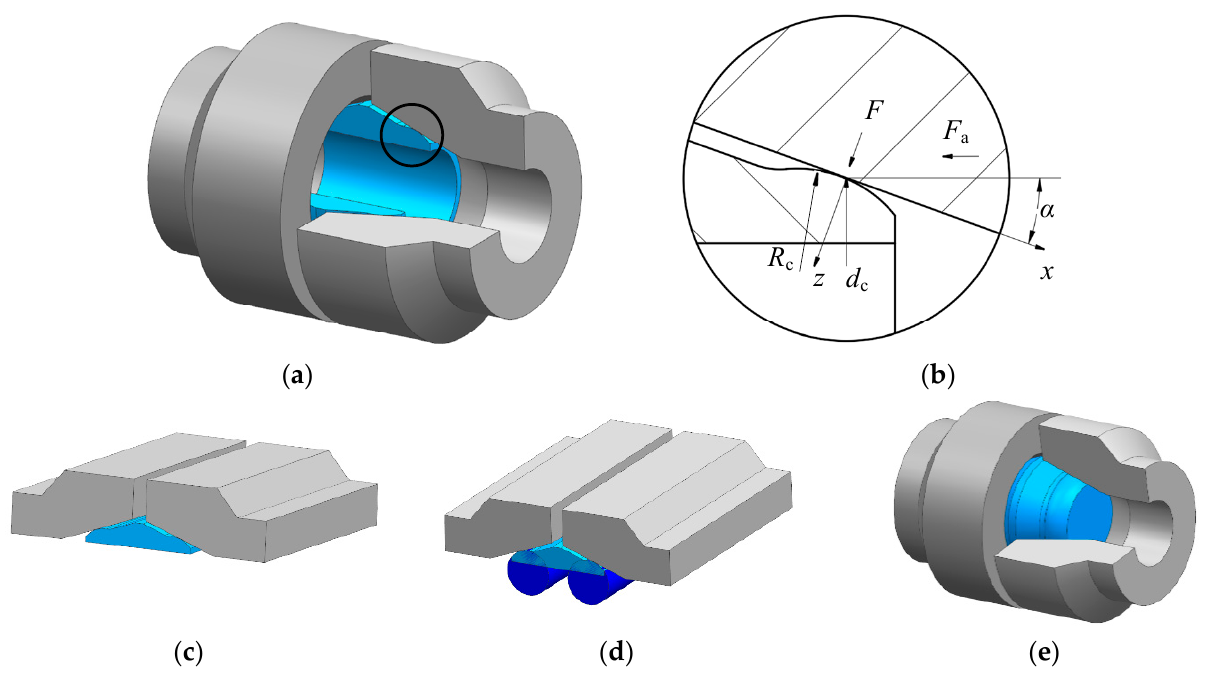
Figure 5. Contact model of flange and metal sealing gasket. ( a ) Actual contact model; ( b ) Cross section of the contact point; ( c ) Tangential expansion; ( d ) Cylinder model; ( e ) Calculation model.